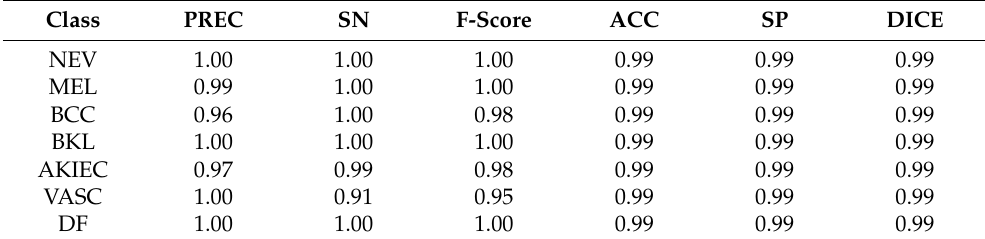
Table 3. The optimized CNN model evaluated on the HAM10000 dataset.